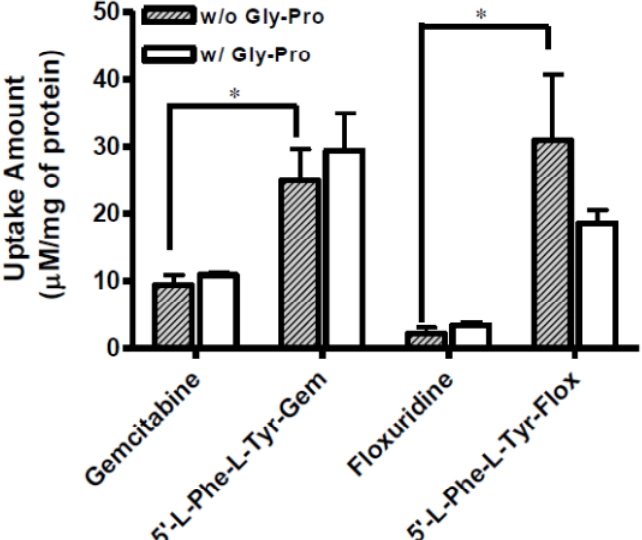
Figure 2. The uptake study with floxuridine, 5 ′ - L -phenylalanyl- L -tyrosyl-floxuridine, gemcitabine, and 5 ′ - L -phenylalanyl- L -tyrosyl-gemcitabine found in Caco-2 cells with 1 h incubation with both the presence and the absence of 10 mM Gly-Pro. Each column represents total amount of floxuridine/gemcitabine prodrug, floxuridine/gemcitabine, and 5-FU/cytosine. Data are expressed as the amount, µM/mg of protein, mean ± SD, n = 3. * p < 0.05, the uptake amount of dipeptide prodrugs is compared with their parents, floxuridine and